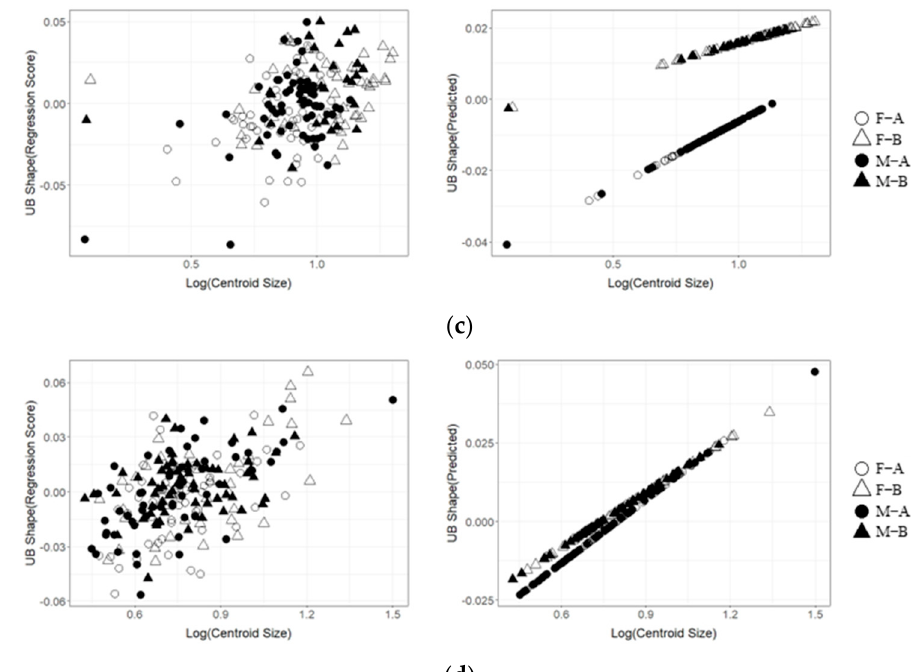
Figure 5. Correlativity of the regression scores of upper beak shape and predicted values versus log(Centroid Size). F–A: Immature, female; F–B: Mature, female; M–A: Immature, male; M–B: Mature, male. ( a ) Octopus minor . ( b ) Uroteuthis edulis . ( c ) Sepia esculenta . ( d ) Sthenoteuthis oualaniensis .